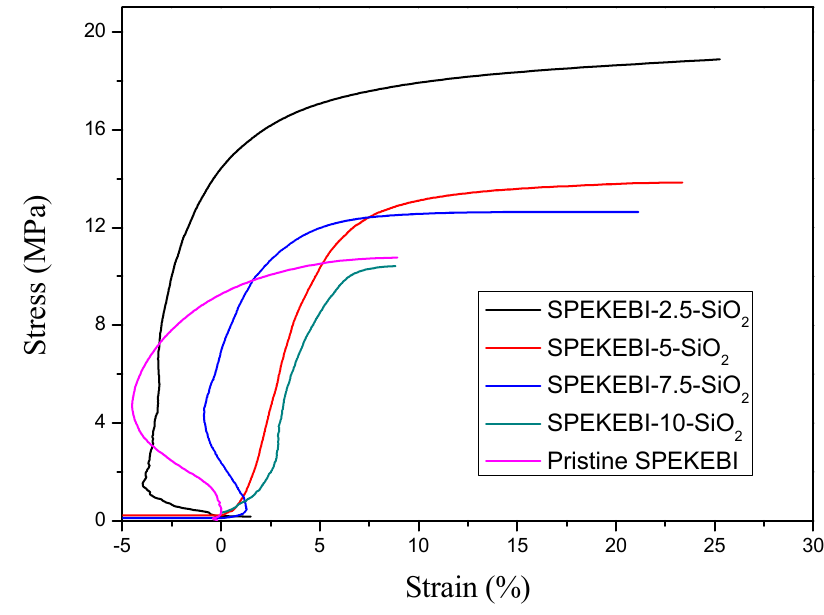
Figure 7. Stress vs. Strain curves of pristine SPEKEBI andSPEKEBI-x-SiO 2 membranes.